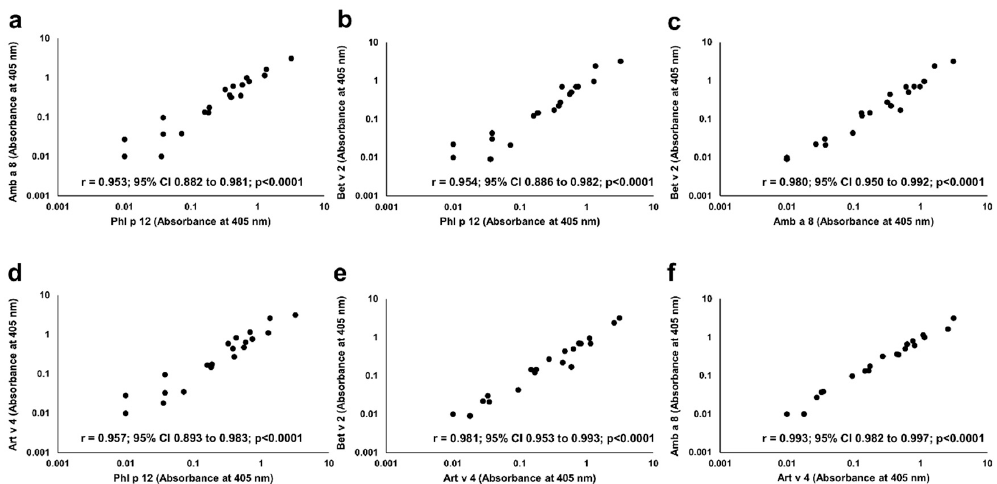
Figure 6. Correlation between IgE binding to individual recombinant profilins. Pairwise comparison of IgE ELISA results performed with Amb a 8 ( a , c , f ), Art v 4 ( d , e , f ), Bet v 2 (b, c, e) and Phl p 12 ( a , b , d ) is depicted on individual charts.